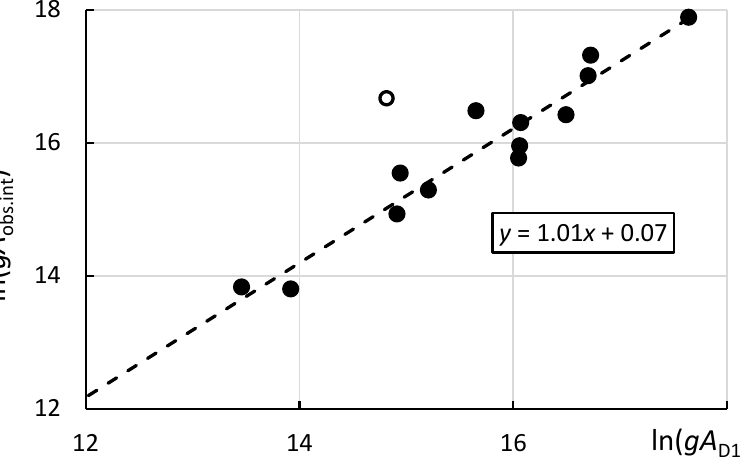
Figure 2. Comparison of observed line intensities with calculated transition rates ( gA values) of Dzuba et al. [3]. The quantity gA obs.int. on the vertical axis represents the gA values derived from observed intensities reduced in the present work to a common linear scale (see Section 6). The empty circle represents the line at 5228.31 Å tentatively identified in this work as the transition from the 6d7s( 3 D)7p 4 D ◦ level to the ground level (see the text). This transition was excluded from the linear 5/2 fit depicted by the dashed